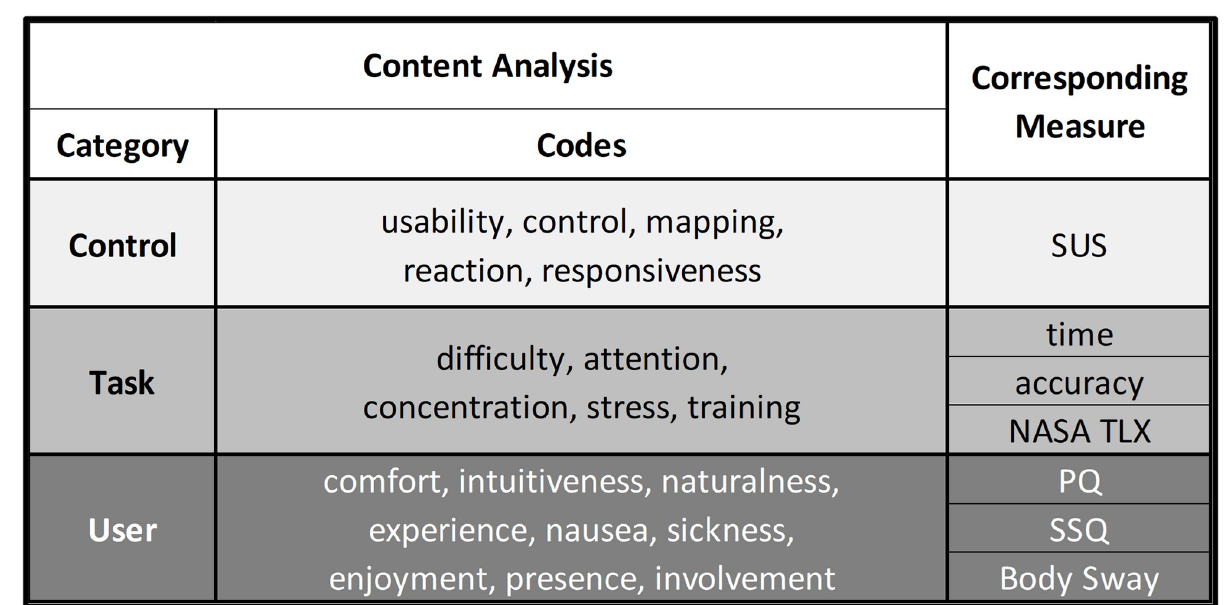
Fig 5. Categories and codes of the content analysis and the measures and questionnaires to which they correspond. chair. The ANOVA for NASA TLX did not reveal a main effect of order or an interaction, but self-reported workload was lower for the gamepad ( M = 4.5, SD = 1.23) than the chair